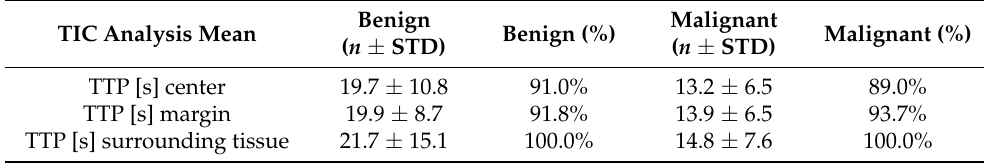
Table 5. Average absolute and relative time to peak (TTP) [s] measurements of benign and malignant thyroid nodules: in their center, along their margins and in the surrounding thyroid tissue.